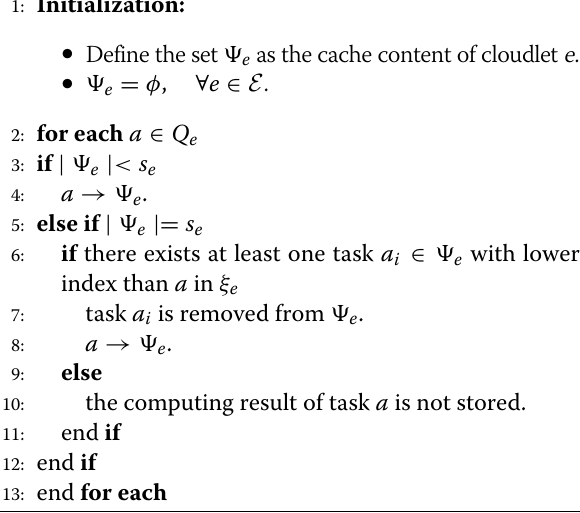
Algorithm 2 Proactive task caching